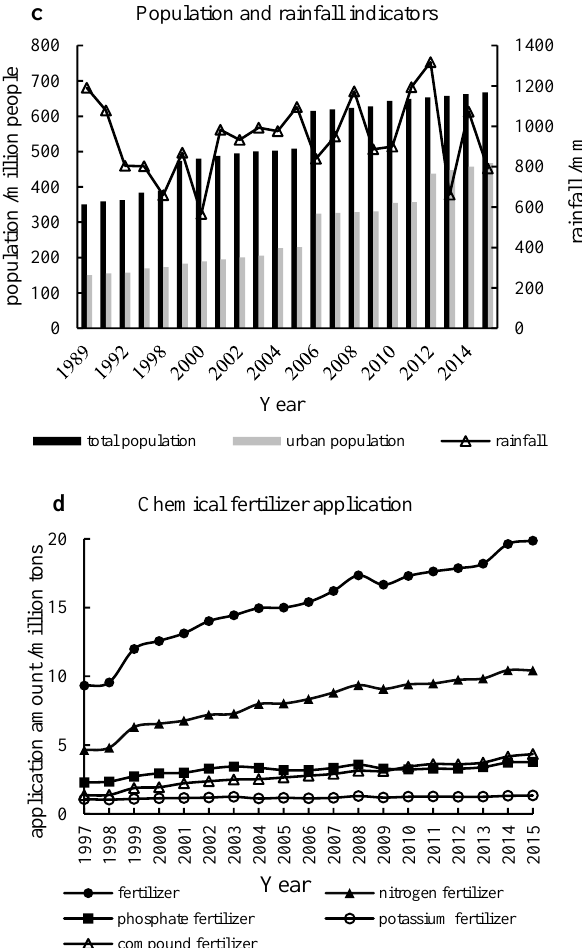
Figure 5. The possession of vehicles and gross industrial output ( a ), gross production ( b ), total population, urban population and rainfall ( c ), and crop fertilization ( d ) in Kunming over time.